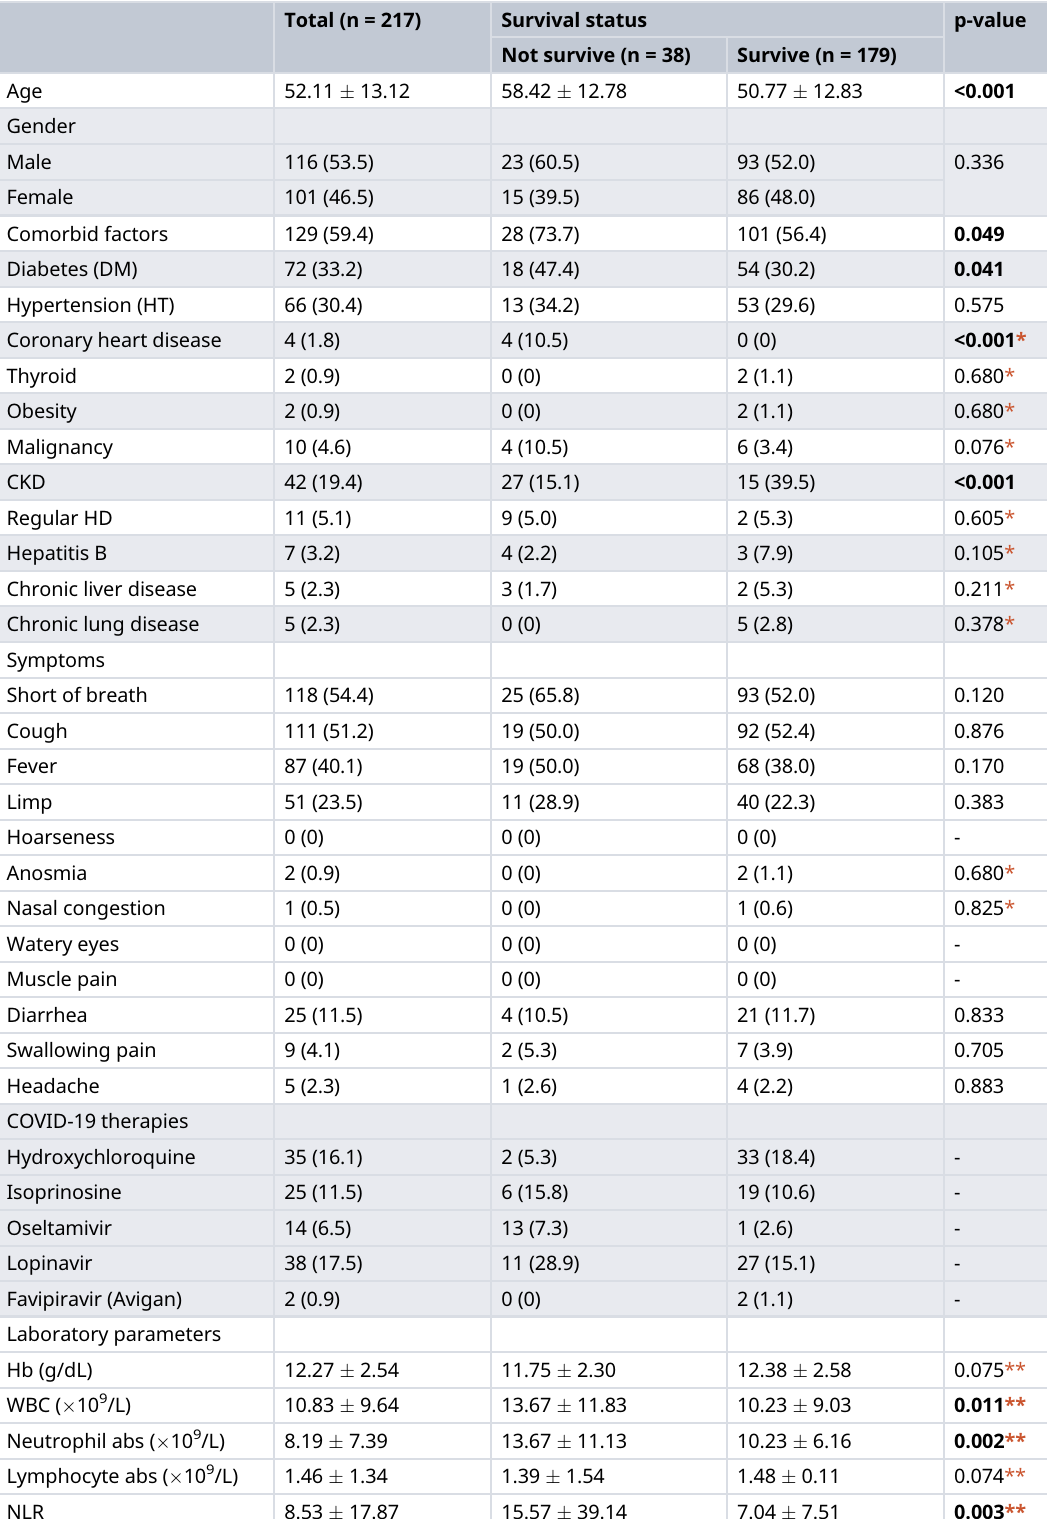
Table 1. Laboratory and clinical overview of the deceased and survived